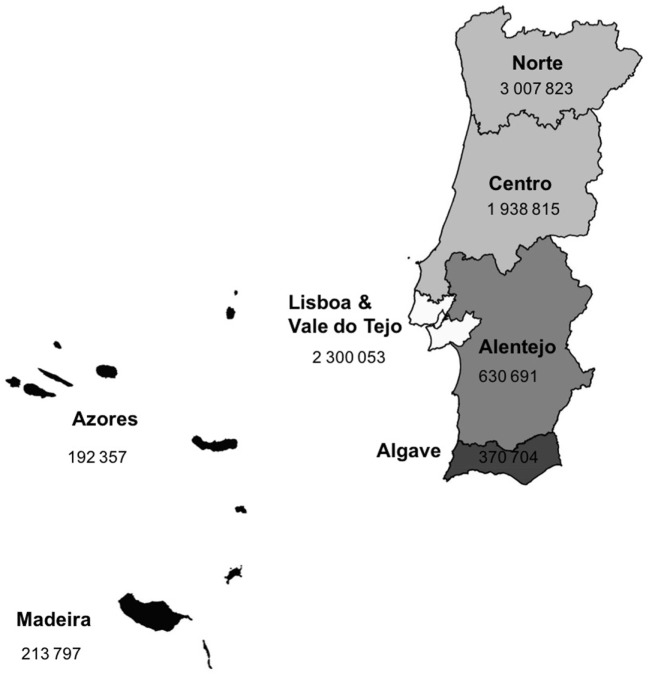
Portugal population density distribution.